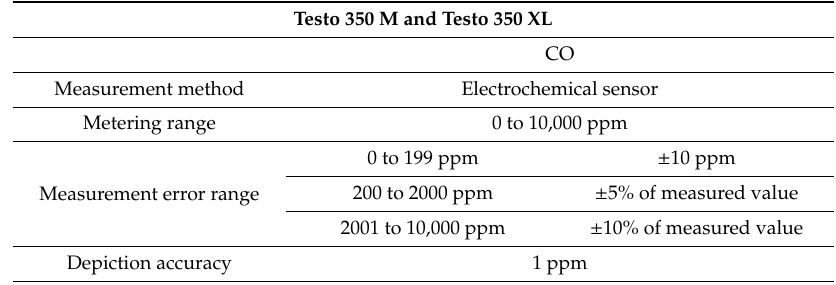
Table A2. Carbon monoxide measurement method and measurement error range stated by Testo 350 analyzer series manufacturer [47].